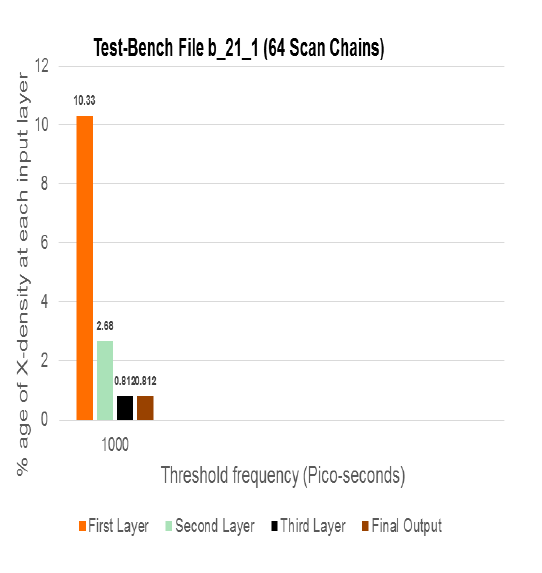
FIG. 9: TEST BENCH FILE B21_1(64 SCAN CHAINS)